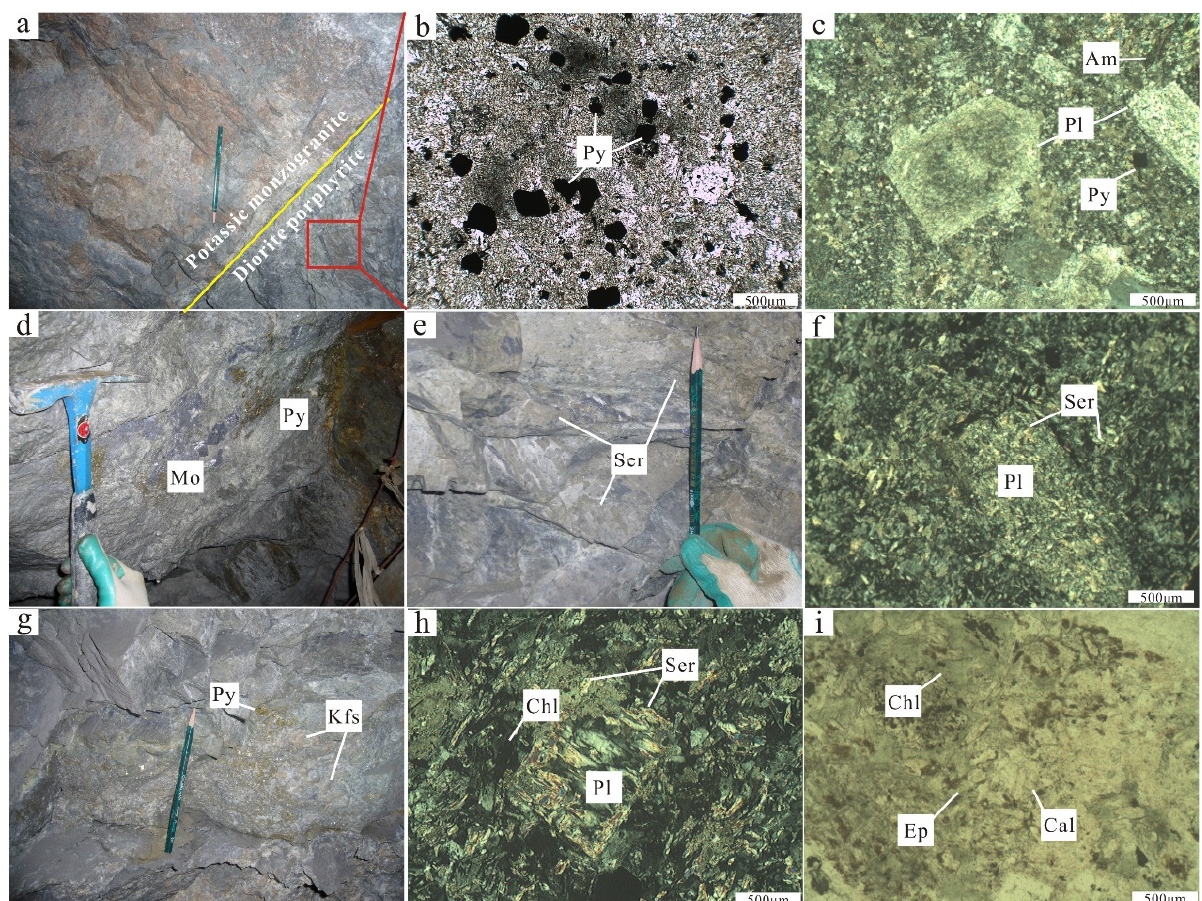
Figure 3. Ore and alteration styles of the Suishizi Au deposit. ( a ) Diorite porphyrite ore and surrounding monzogranite; ( b ) pyrites in diorite porphyrite ore; ( c ) pyrites and phenocrysts in diorite porphyrite ore; ( d ) metal sulfidation and silicification; ( e , f ) sericitization; ( g ) potash feldspathization + silicification; ( h , i ) chloritization + epidotization + carbonatization. Kfs, K-feldspar; Pl, Plagioclase; Am, Amphibole; Ser, sericite; Chl, chlorite; Cal, calcite; Ep, epidote; Py, pyrite; Mo, molybdenite .